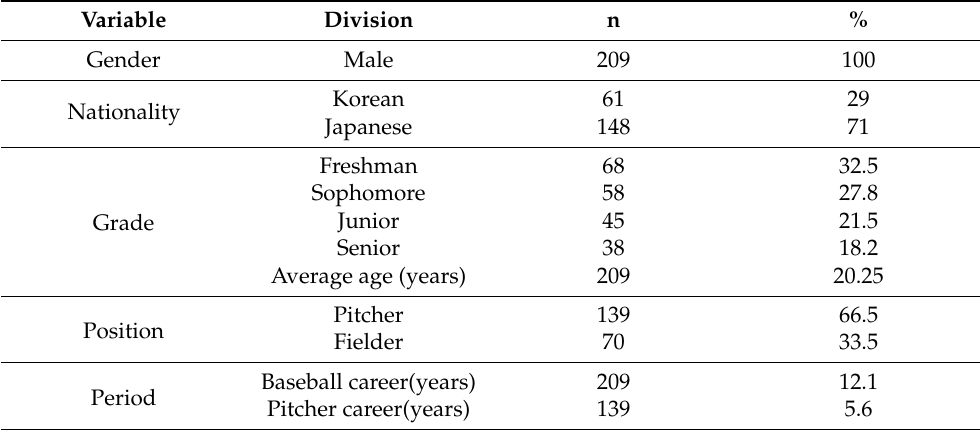
Table 1. Characteristics of participants (n = 209).